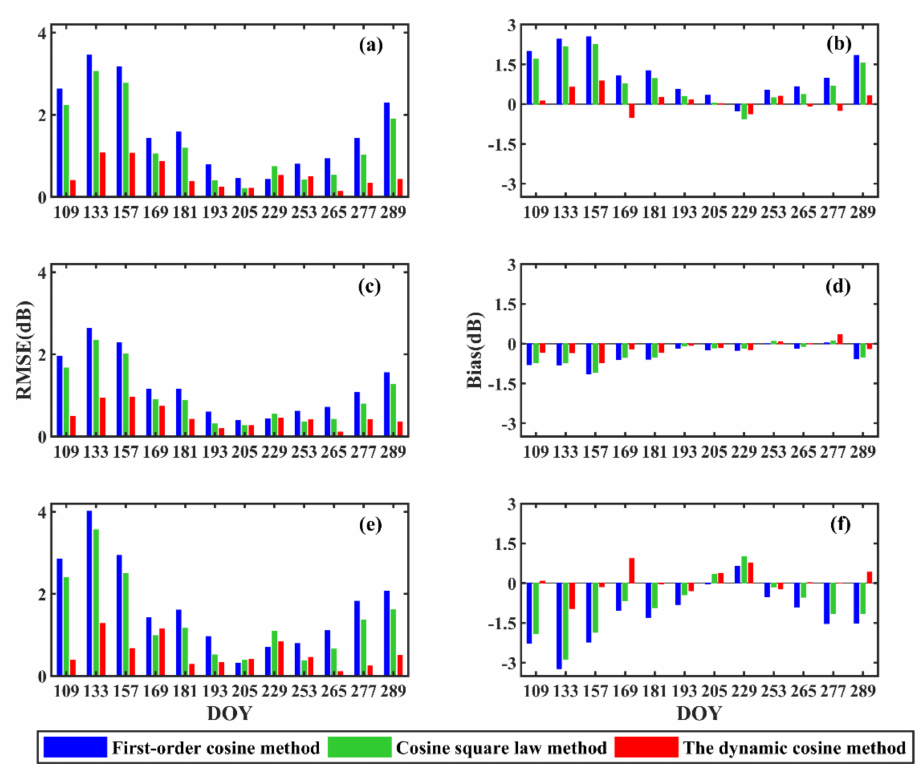
Figure 10. The RMSE and bias of first-order cosine method, cosine square law method, and dynamic cosine method (VV polarization). ( a ), ( c ), and ( e ) represent the RMSE for 34 ◦ , 40 ◦ , and 44 ◦ , respectively; ( b ), ( d ), and ( f ) respectively represent the deviation bias for 34 ◦ , 40 ◦ , and 44 ◦ .